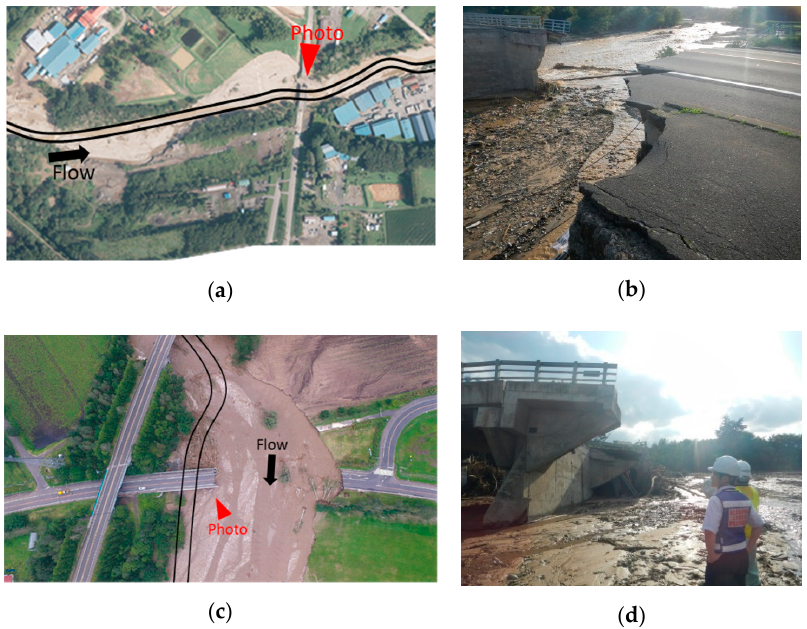
Figure 1. Examples of bridge damage after the heavy rainfalls in August 2016 in Hokkaido, Japan. ( a ) Aerial photo of Kiyomi Bridge (43°00’23.1” N 142°53’30.8” E), ( b ) Close-up view of Kiyomi Bridge, ( c ) Aerial photo of Kobayashi Bridge (42°58’16.5” N 142°53’34.7” E), ( d ) Close-up view of Chiroro Bridge. Black lines show the riverbank before the flood; red triangles show the locations of close-up photos.